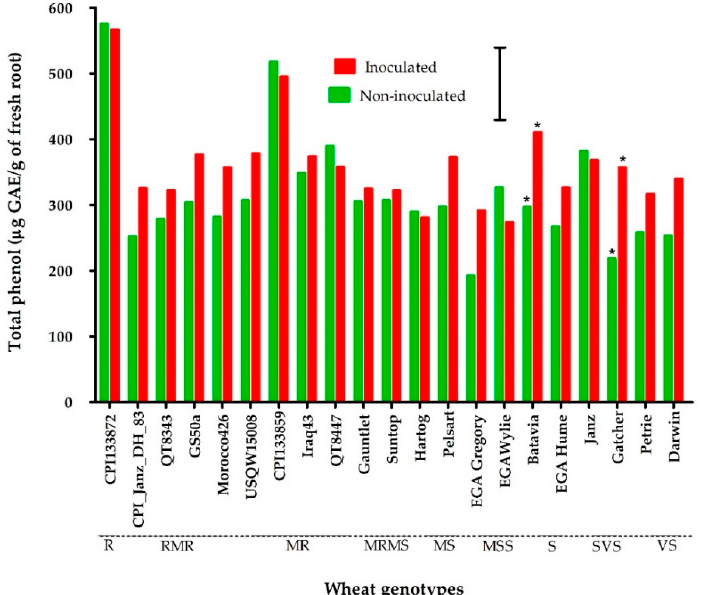
Figure 3. Total phenols (µg gallic acid equivalent (GAE)/g of fresh root) at 8 weeks in the roots of Pratylenchus thornei inoculated (red) and non-inoculated (green) wheat genotypes ranging in resistance and susceptibility to Pratylenchus thornei . The values are the means of three replications. * represent a statistically significant di ff erence ( p < 0.05) between inoculated and non-inoculated treatments of a genotype. The bar marker indicates LSD = 110 ( p = 0.05) for the interaction genotype* P. thornei . The resistance rating of each wheat genotype is shown along the